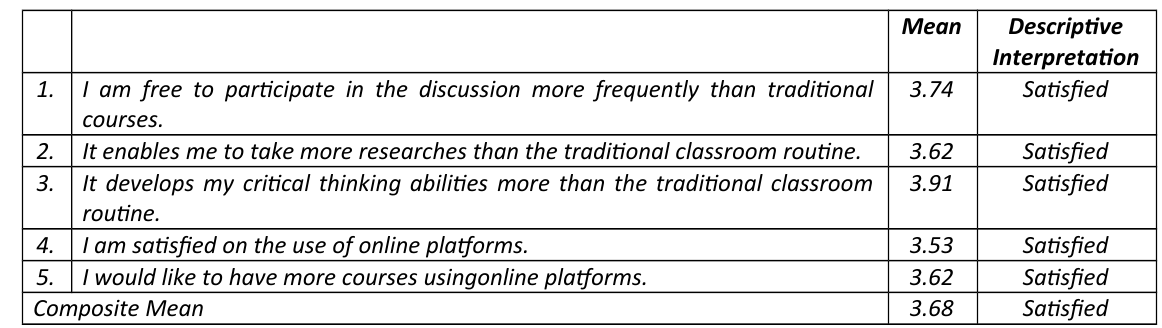
Table 4.The Perceived Satisfaction of Online Scaffolding in the Students’ Learning Activities